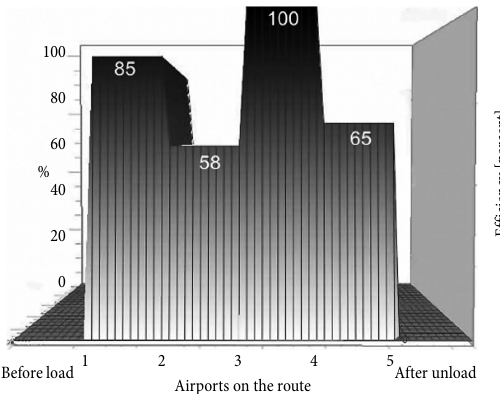
Fig. 12. The efficiency is similar but profit increased (the strong influence has the contingent 6 (3–4) that is more valuable than